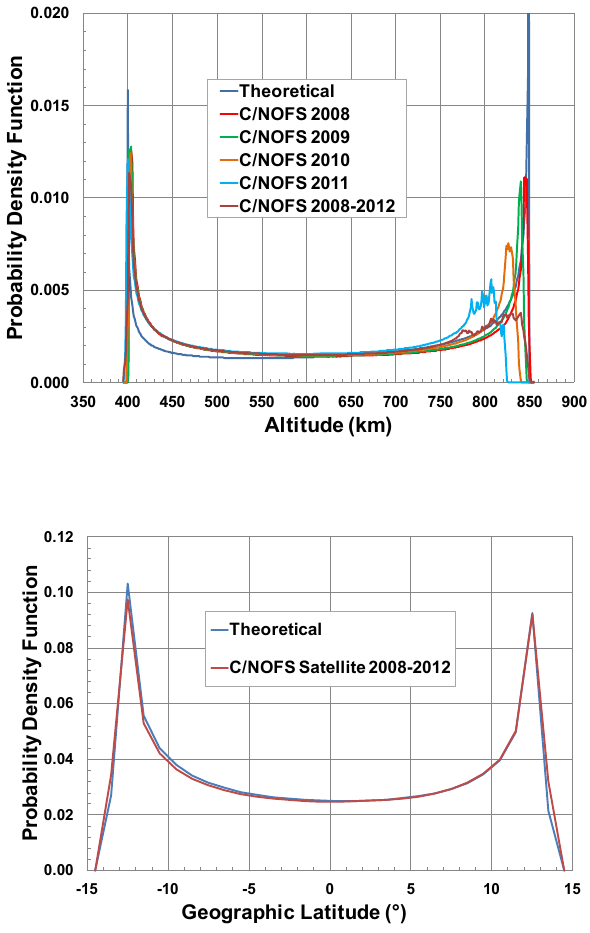
Figure 3. The pdfs of the C/NOFS satellite altitude (top) for dif- ferent years and an extended period, as well as of the geographic Figure 3. Probability density functions (pdfs) of the C/NOFS satellite altitude (top) for different latitude (bottom) for the same extended period, estimated from the years and an extended period, as well as of the geographic latitude (bottom) for the same data files. Also shown are the corresponding pdfs predicted by a theoretical model (Fortes et al., 1999; ITU-R, 2001) assuming nom- extended period, estimated from the data files. Also shown are the corresponding pdfs predicted inal orbital parameters (inclination 13 ◦ , perigee and apogee approx- by a theoretical model (Fortes et al., 1999; ITU-R, 2001) assuming nominal orbital parameters imately equal to 400 and 850km, respectively). Each of the above curves is normalized in such a way that the pdf values at their break (inclination 13 o , perigee and apogee approximately equal to 400 km and 850 km, respectively). points add to Each of the above curves is normalized in such a way that the pdfs values at their break points add to one.